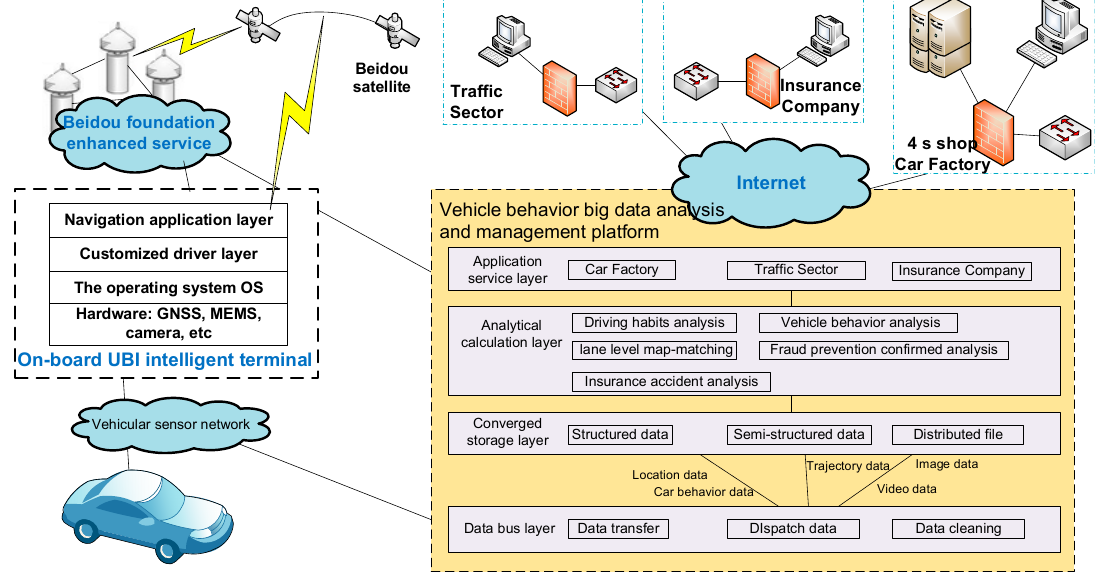
Figure 1. ‘Terminal-Platform-Application’ trinity framework.